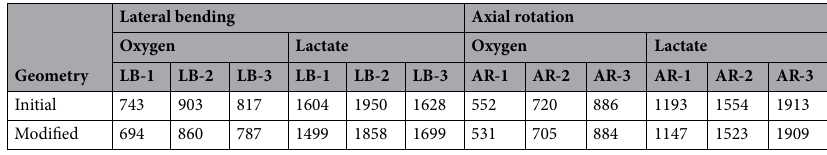
Table 4. Peclet number associated with O 2 and lactate at t = 1 s for each configuration.